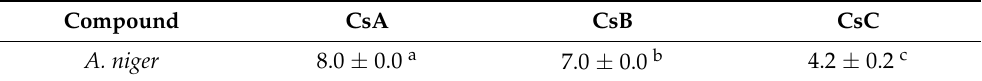
Table 1. Inhibition zone radius (mm) of cyclosporins A–C (CsA–C) against A. niger . Compound